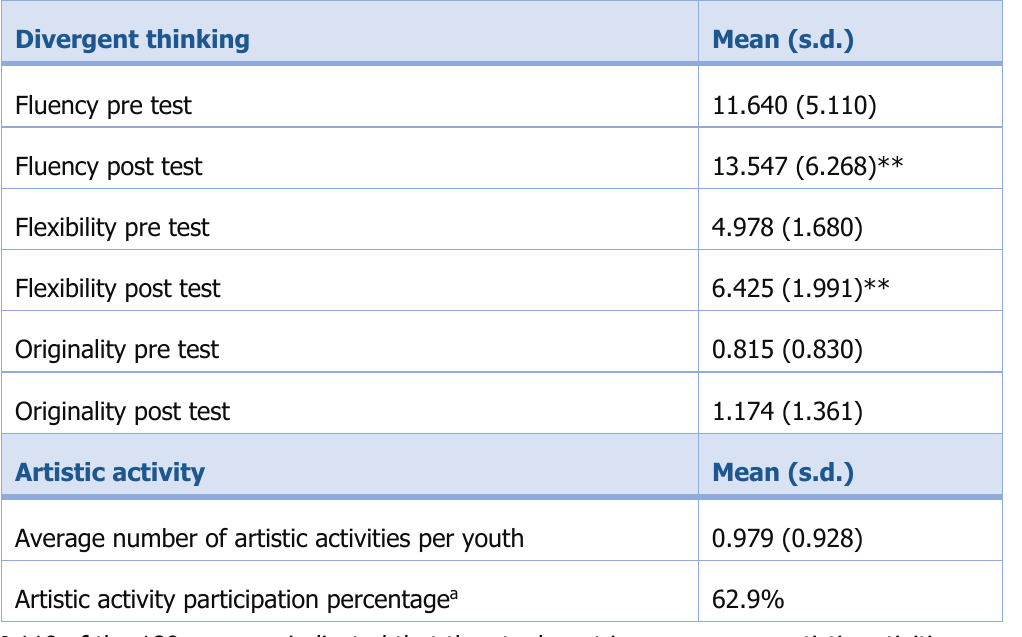
Table 2. Descriptive Statistics for Divergent Thinking and Activity Type (N =